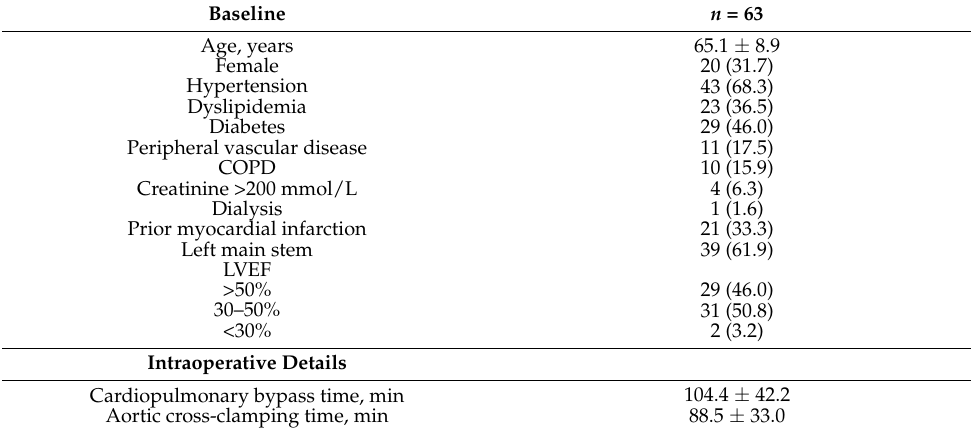
Table 1. Patients’